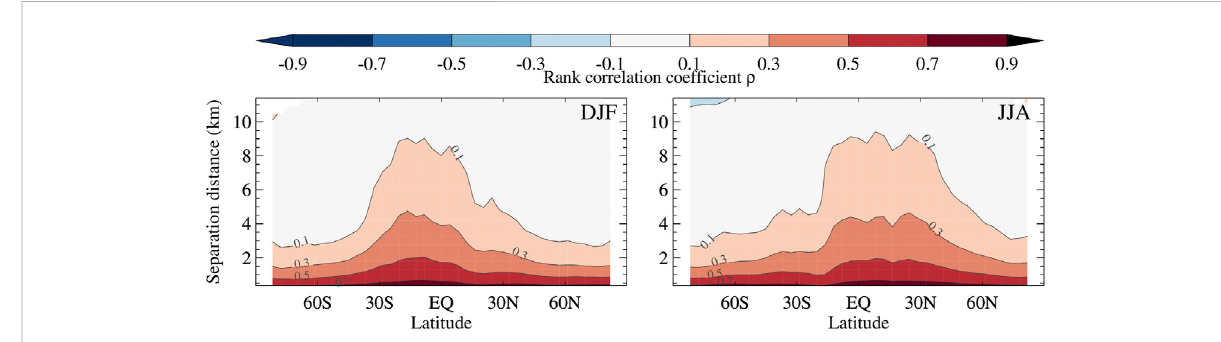
Frontiers in Remote